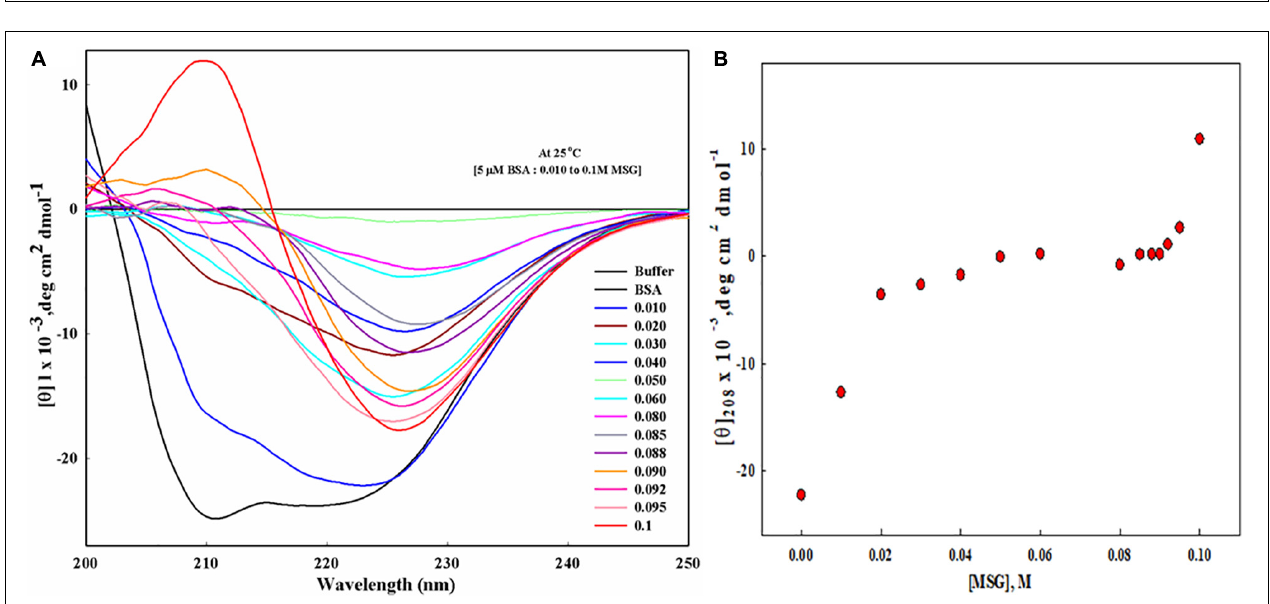
FIGURE 6 | (A) Determination of reversibility of BSA in the presence of monosodium glutamate. (B) Influence of MSG on the measurement of the hydrodynamic size of bovine serum albumin.